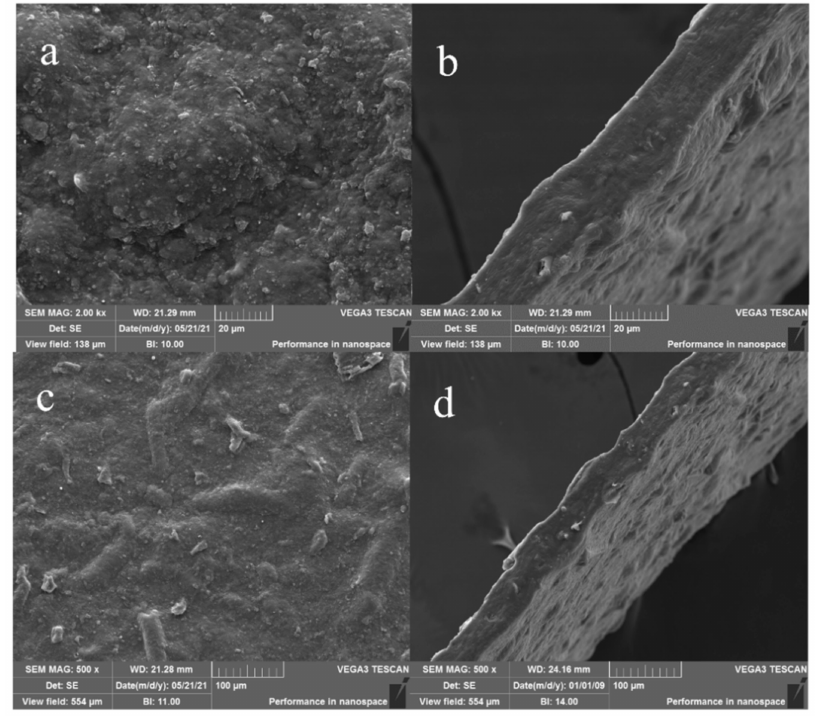
Figure 4. The micrographs of YPP-SA-G film. ( a ) 2000 × magnification (Surface); ( b ) 2000 × magnifi- cation (Cross section); ( c ) 500 × magnification (Surface); ( d ) 500 × magnification (Cross